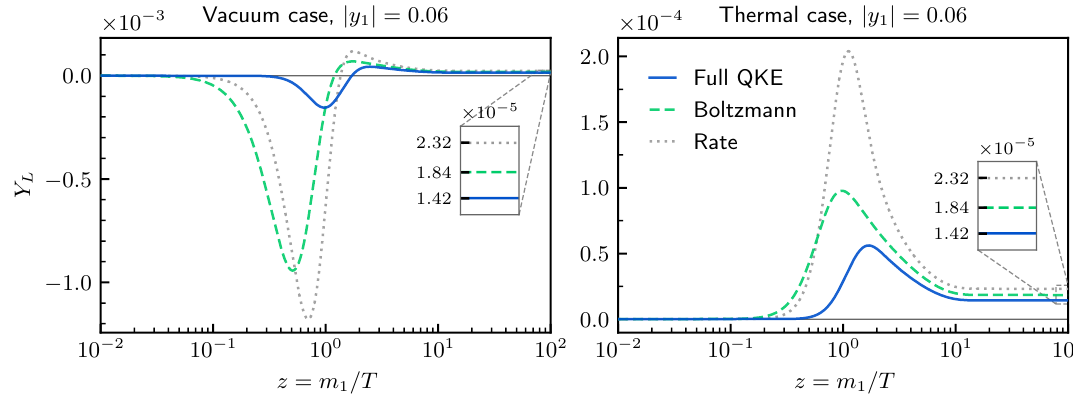
Figure 7. Numerical solutions for the lepton asymmetry Y L ( z ) from our main equation (6.11) (solid line), Boltzmann equation (G.6) (dashed line) and rate equation (G.20) (dotted line). We used the benchmark parameter values (7.7). The left (right) panel has vacuum (thermal) initial conditions for the Majorana neutrinos. The final values of the asymmetries are shown as insets.